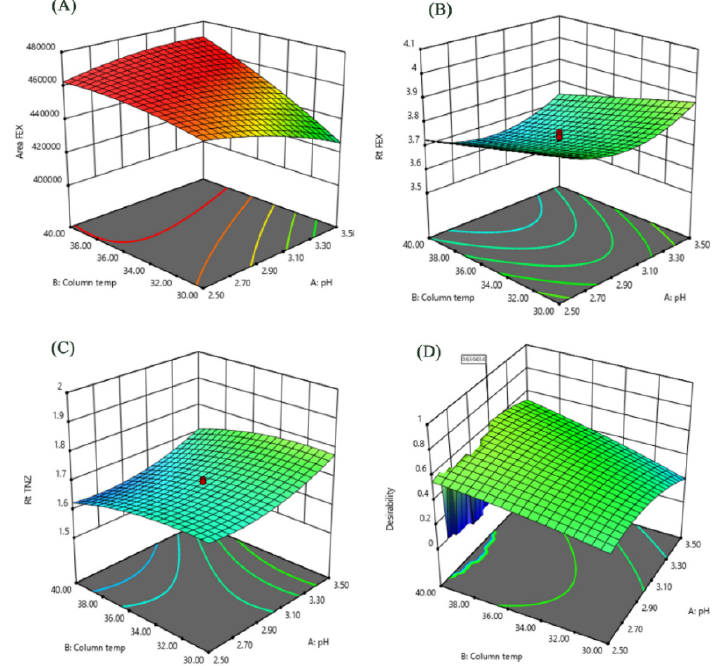
Figure 3. Calculated response surfaces show the interaction of pH and Column temperature on ( A ) Fexofenadine HCl peak area, ( B ) Fexofenadine HCl retention time. ( C ) Tinidazole (IS) retention time and ( D ) desirability function results.